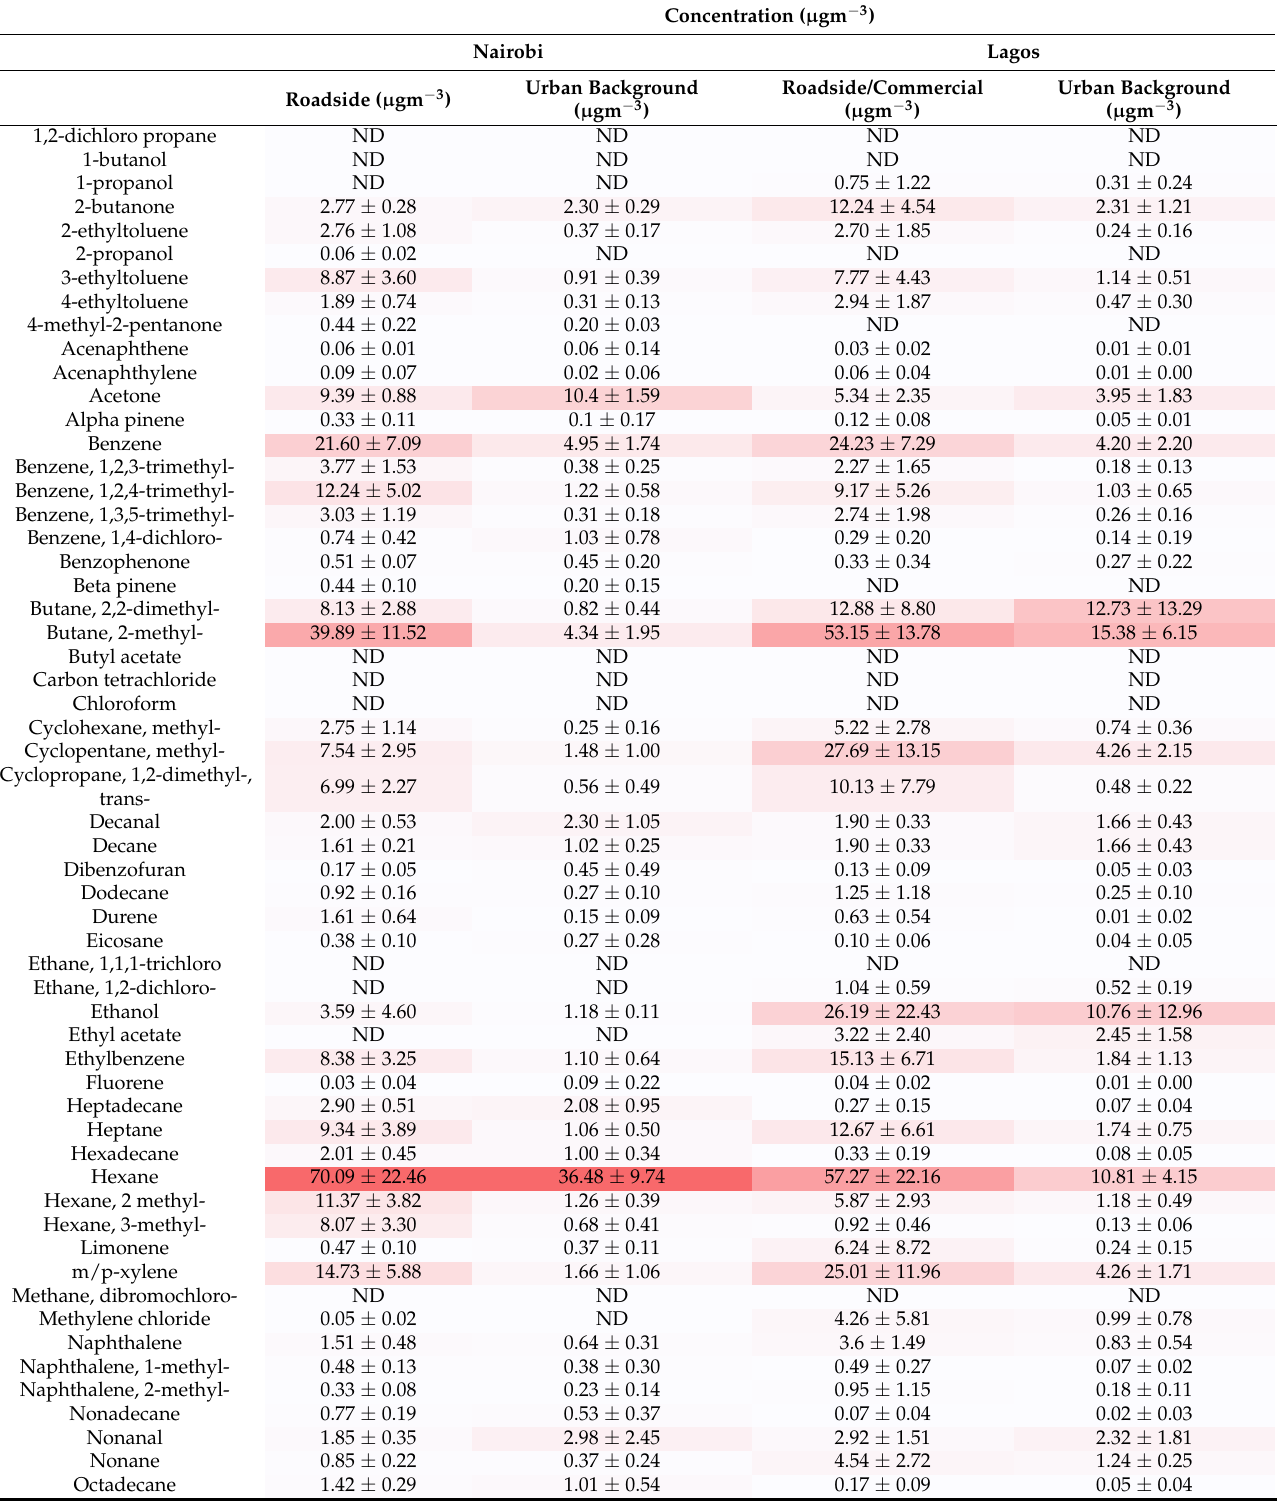
Table 2. Target VOCs averaged ( ± standard deviation) across urban background (UB) and roadside (RS) sites in Nairobi and Lagos, coloured by maximal value per sample